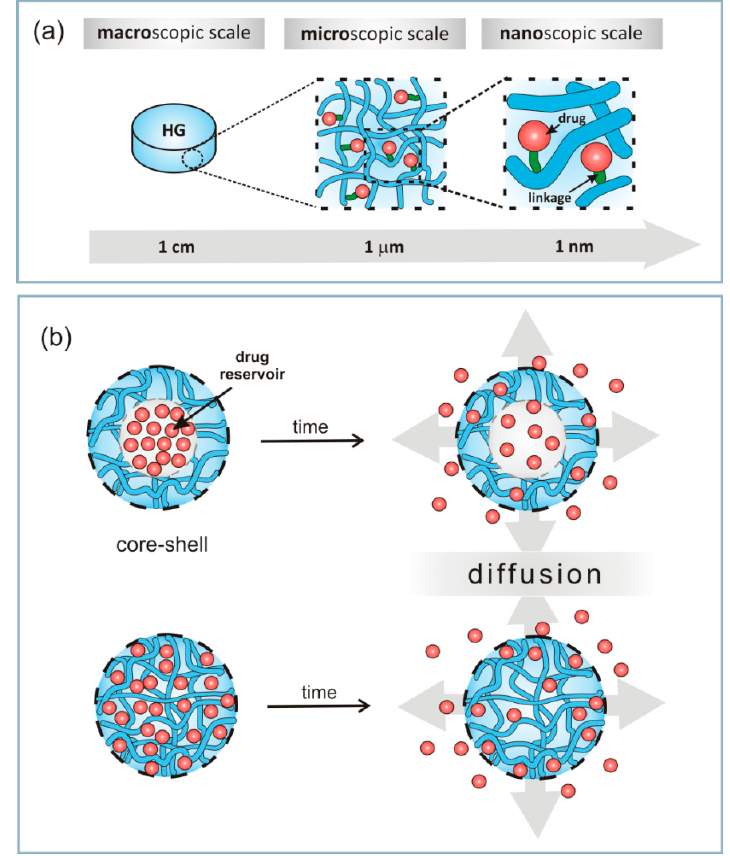
Figure 3. ( a ) Macroscopic design of HGs including the size and porous structure. ( b ) Schematic structures of micro- and nanogels showing the release of drugs.